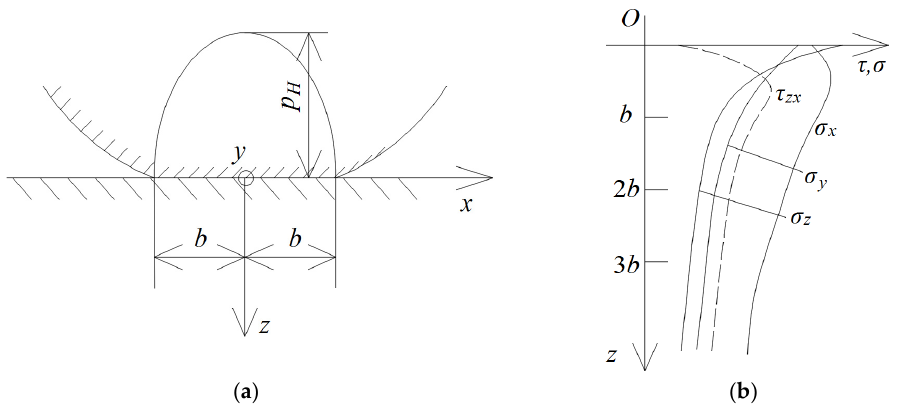
Figure 7. Images of ( a ) Hertz elastic model of two contact counterfaces and ( b ) stress as a function of subsurface position, where p H is the maximum stress, and b is the half width of the contact line.